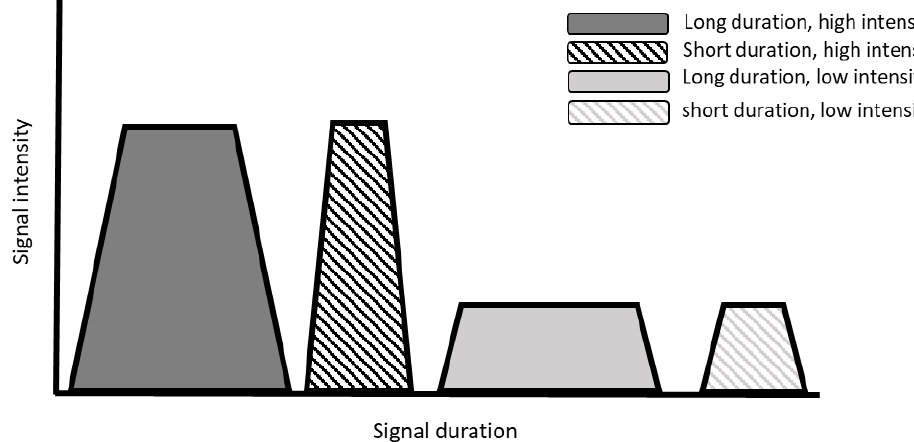
Figure 2. Schematic overview of our hypothesis underlying oro-sensory exposure. The area under the curve represents the level of oro-sensory exposure, which depend on both the intensity and the duration of the sensory